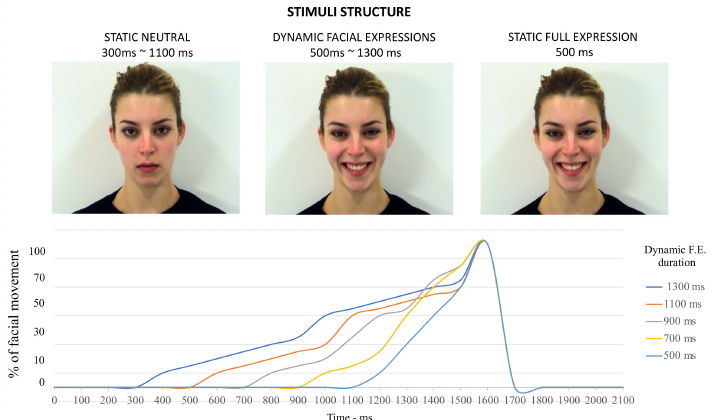
Figure 1. The structure of each video stimulus, characterized by a static neutral face followed by the dynamic production of an emotional facial expression (which varied in duration), and a subsequent static period where the full expression was held at its peak (500 ms). The plot below shows an approximation of the different percentages of the dynamic component of each stimulus as a function of time for each possible duration (500 ms~1300